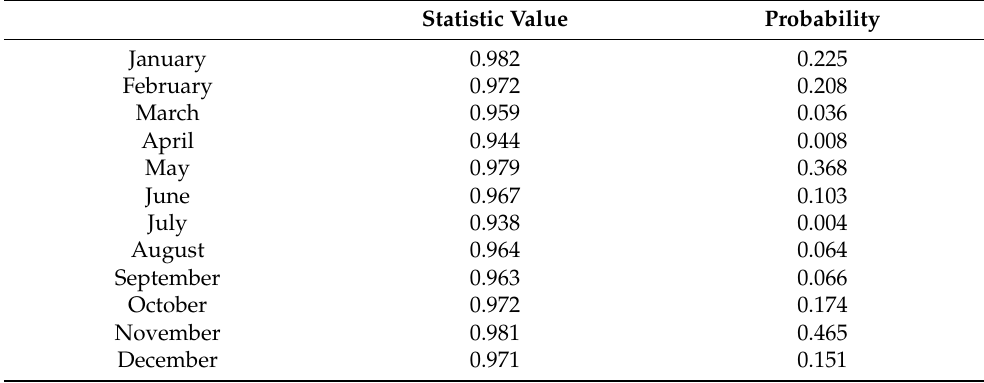
Table 2. Shapiro–Wilk test